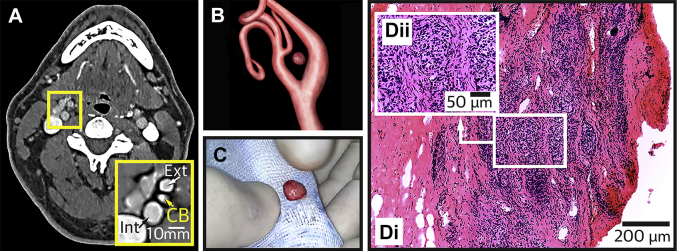
Confirmation of the CB in Resected Tissue(A) Computed tomography scan of a patient at the level of the carotid bifurcation. Inset is magnified image showing the internal (Int) and external (Ext) carotid arteries and the carotid bod (CB) (arrows). (B) 3-dimensional reconstruction of the carotid artery bifurcation from computed tomography images showing the precise position of the CB. This CB was surgically resected (C), and histologically confirmed by identification of densely packed glomus cells and the lateral margin of the CB (Di). (Dii) A high power magnification of the boxed area in Di depicting glomus cells. All images are from the same patient. The scans in this image have been enhanced for contrast/sharpness.